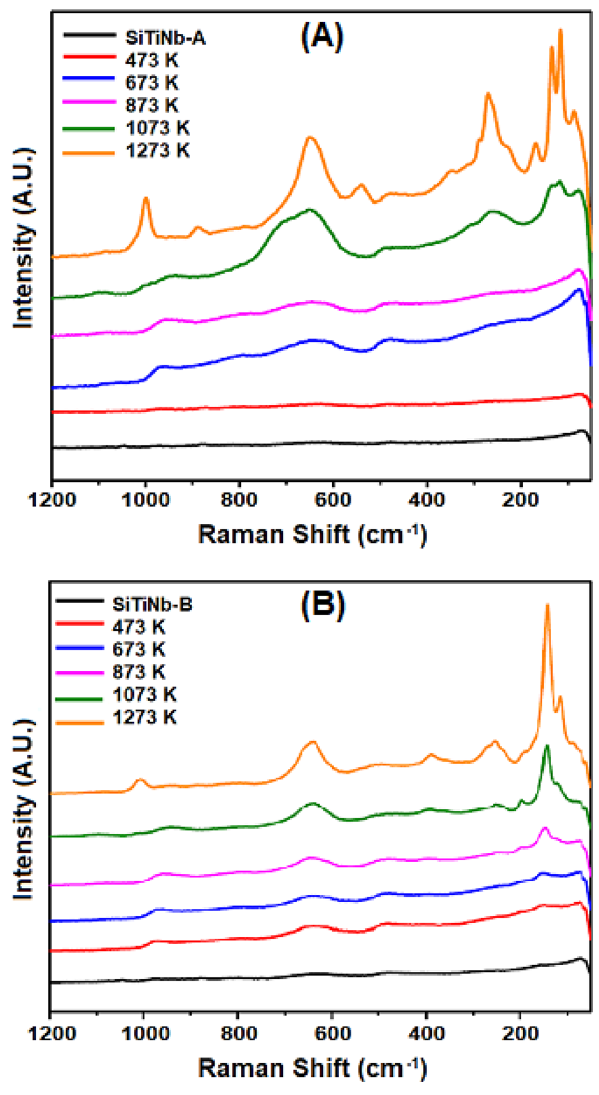
Figure 8. Raman spectra of thermally treated for the SiTiNb-A (A) e SiTiNb-B (B) materials at different temperatures.